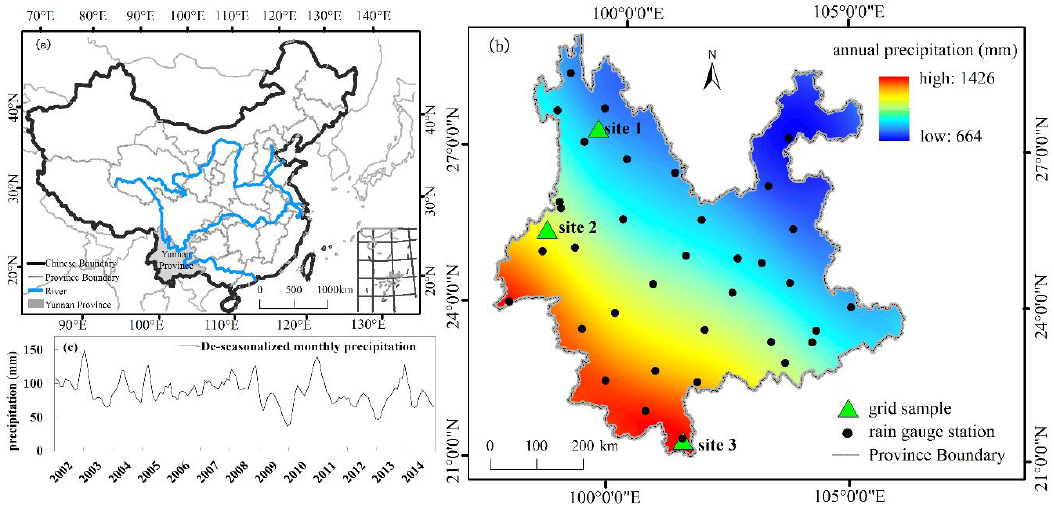
Figure 1. ( a ) Location map; ( b ) average annual precipitation map; and ( c ) time series of de-seasonalized monthly precipitation from 2002 to 2014 in Yunnan Province; triangle symbols in ( b ) represent three samples for the analysis of regional Total Water Storage Anomalies (TWSA) variations.